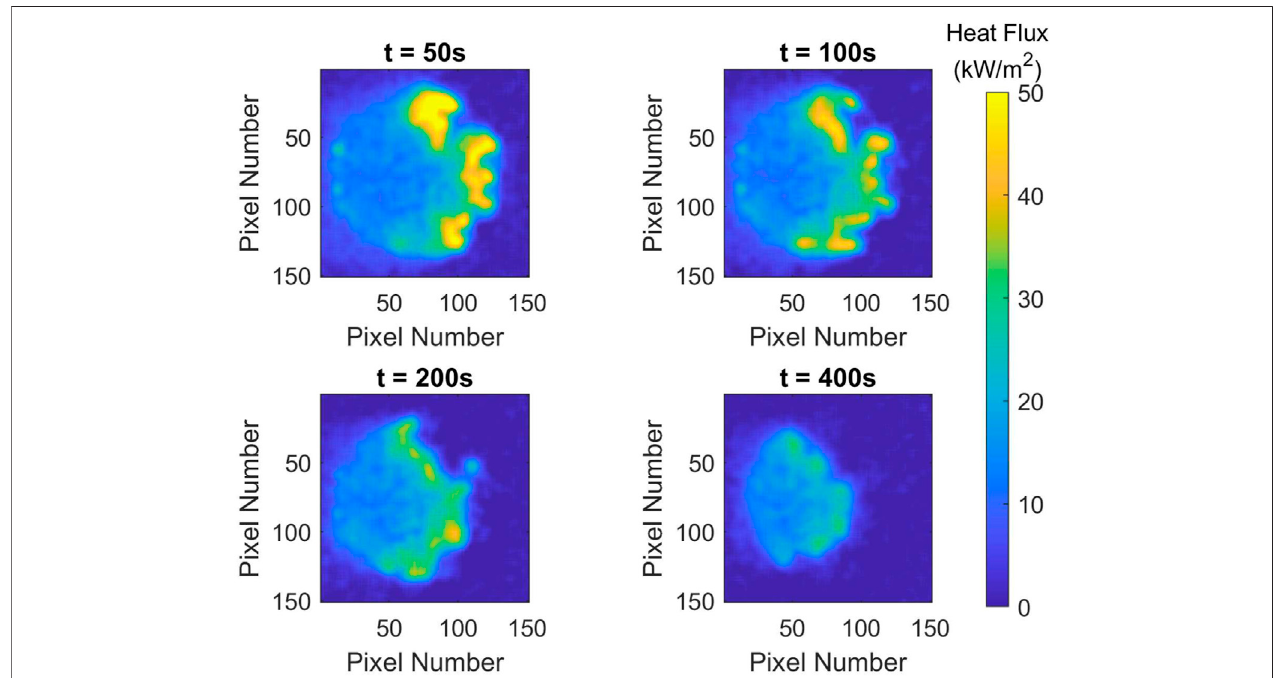
FIGURE 13 | Heat fl ux distribution for test FF13 at different times. Firebrands: D (cid:2) 4.75 mm, L (cid:2) 12.5 mm, and AR (cid:2) 2.6; Pile mass of m (cid:2) 3.0 g; Wind speed: U (cid:2) 2.0 m/s.